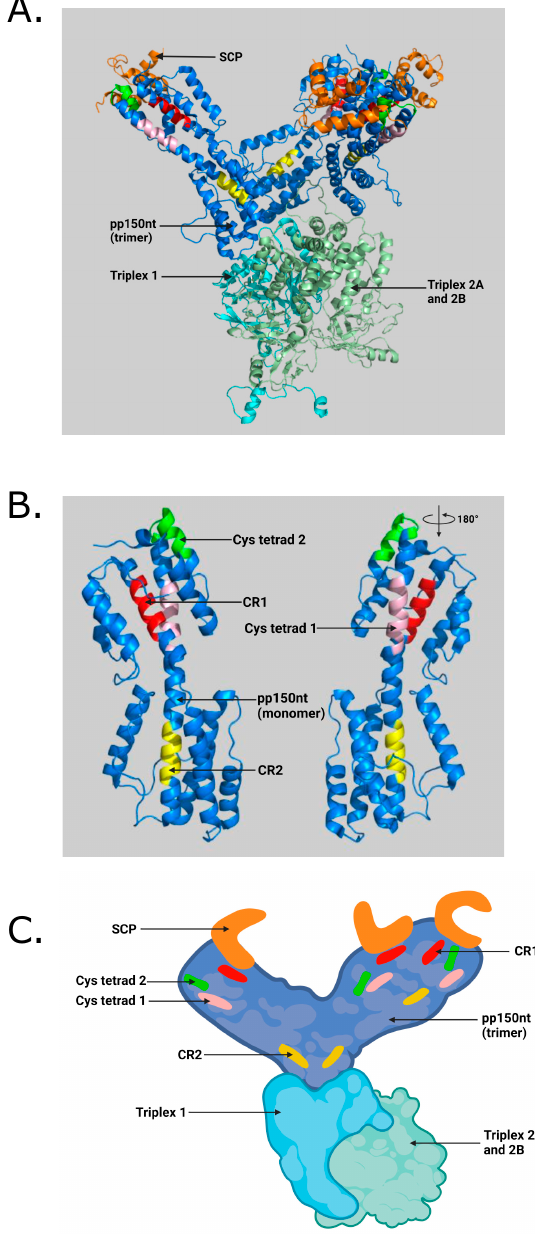
Figure 1. ( A ) Illustration of pp150nt structure and its binding interface with capsid proteins in an HCMV virion. SCP (small capsid protein) binds to MCP (major capsid protein). Triplexes (also known as minor capsid-binding protein) are heterotrimers composed of Tri1 and a Tri2A–Tri2B heterodimer. Three pp150nt residues (pp150nt trimer) cluster above triplexes and extend towards SCP atop nearby MCP, forming a net-like layer of tegument densities. ( B ) Close-up view showing conserved regions in pp150 monomer generated by PyMOL software (Schrödinger, LLC) using RSCB PDB ID: 5VKU and UNIPROT ID: Q6SW99. ( C ) Cartoon illustration of pp150nt trimer and its binding interface with capsid proteins in an HCMV virion generated with BioRender.com (access date: 10 November 2021) Orange—SCP; Blue—pp150nt; Cyan—Triplex 1; Pale green—Triplex 2A and 2B; Red—pp150 conserved region 1 (CR1); Yellow—pp150 conserved region 2 (CR2); Pink—Cysteine tetrad 1; Green—Cysteine tetrad 2